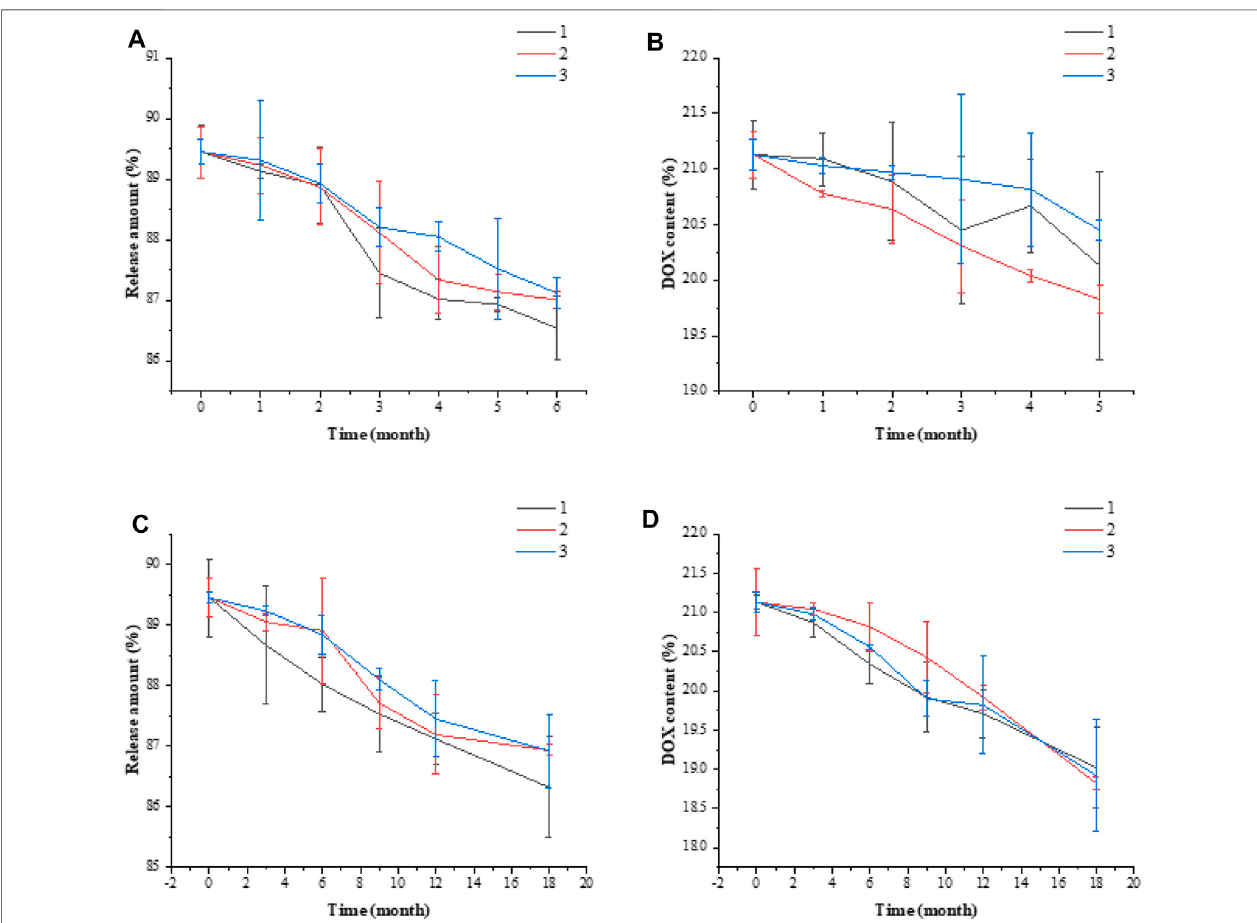
FIGURE 11 | Accelerated stability test release amount (A) , DOX content (B) . Long-term stability test release amount (C) , DOX content (D) . Data are expressed as mean ± SEM ( n = 3).